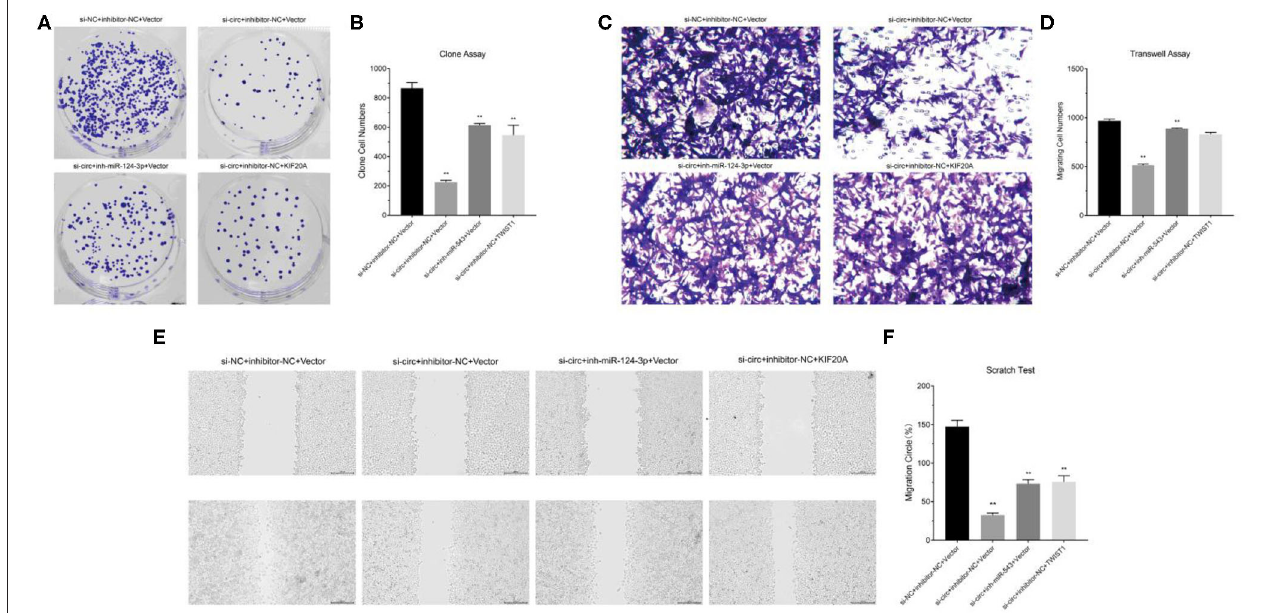
FIGURE 4 | Circ-ASB3 accelerated glioma proliferation, invasion and migration through miR-543/Twist1 axis. (A,B) Colony formation assays detected the cell proliferation ability of A172 cells transfected with si-circ-ASB3, miR-543 inhibitor and Twist1 mimics. (C,D) Transwell assays measured the invasion abilities of A172 cells transfected with si-circ-ASB3, miR-543 inhibitor and Twist1 mimics. (E,F) The migration ability of A172 cells transfected with si-circ-ASB3, miR-543 inhibitor and Twist1 mimics was measured through scratch test (0 and 24h), ** P < 0.01; representative images are presented.